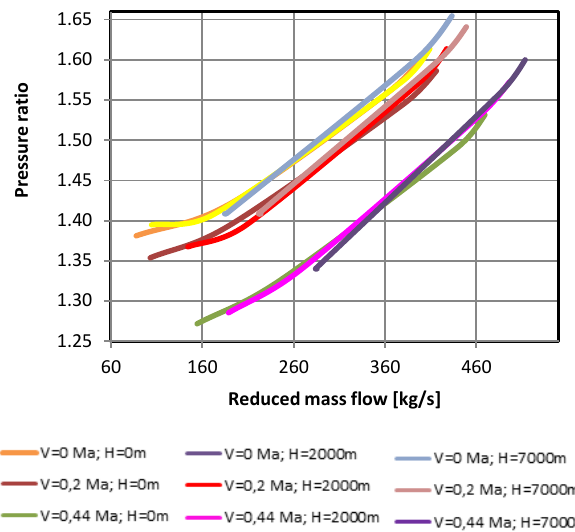
Fig. 5. Compressor map of fan CFM 56-56